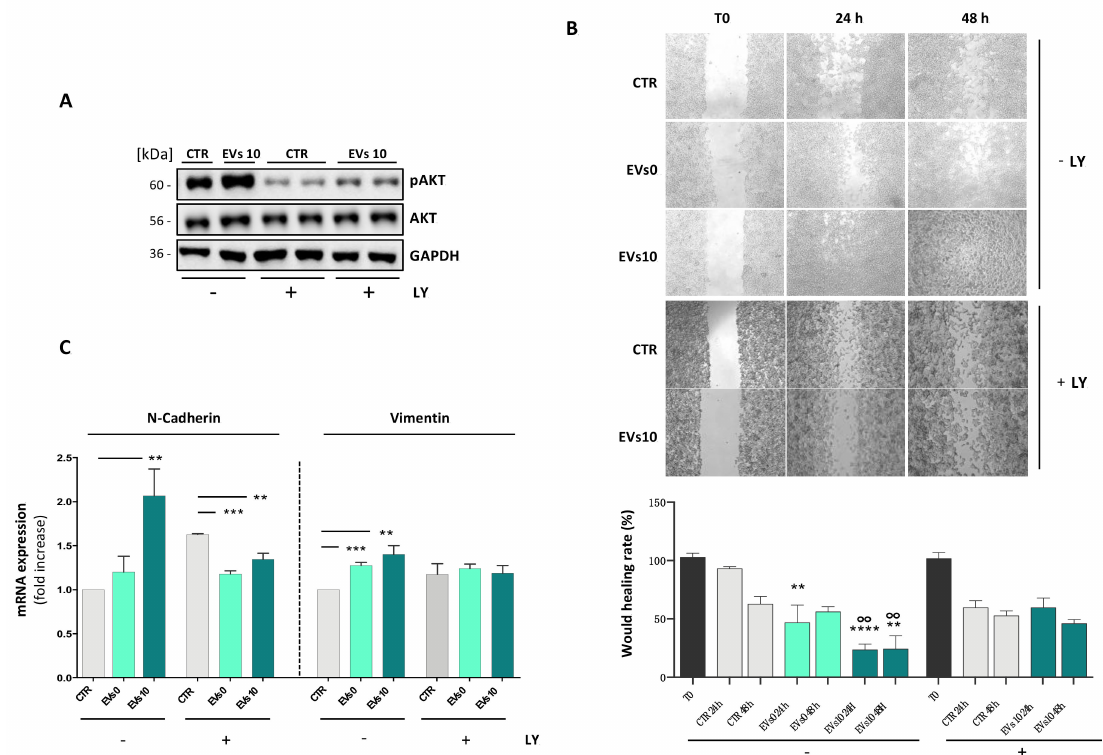
Figure 4. AKT activation is required for EVs-induced SH-SY5Y migration. SH-SY5Y cells were treated/mock treated with LY and then exposed to EVs0 or EVs10. ( A ) Protein levels of pAKT (T308) and AKT were determined by Western blotting using GAPDH as loading control. ( B ) Wound-healing assays were performed using Ibidi Culture-Inserts. Cell migration was recorded at 24 and 48 h after the inserts were removed (upper panel); wound healing rate (bottom panel). ( C ) mRNA expression of N-Cadherin and Vimentin was determined by RT-qPCR. Data are expressed as means ± S.D. (n = 3, ** p < 0.01, *** p < 0.001, **** p < 0.0001, vs. CTR; n = 3, ◦◦ p < 0.01, vs.